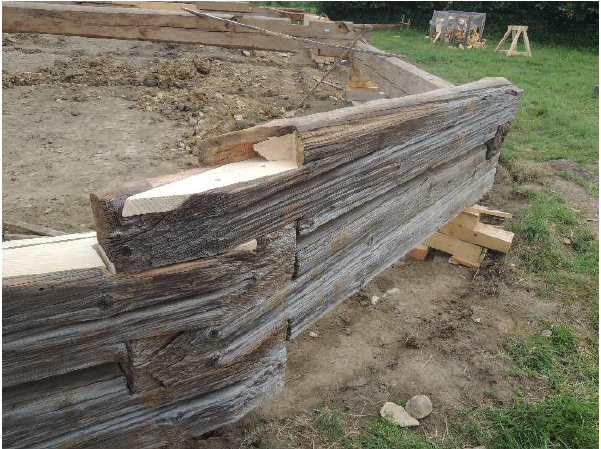
Figure 20. The repaired beam put back to its original place in the barn timber wall.